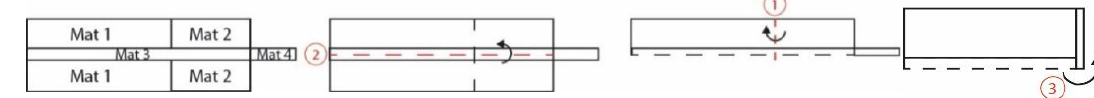
Figure 11. Crossfolding of final structure of method 1.